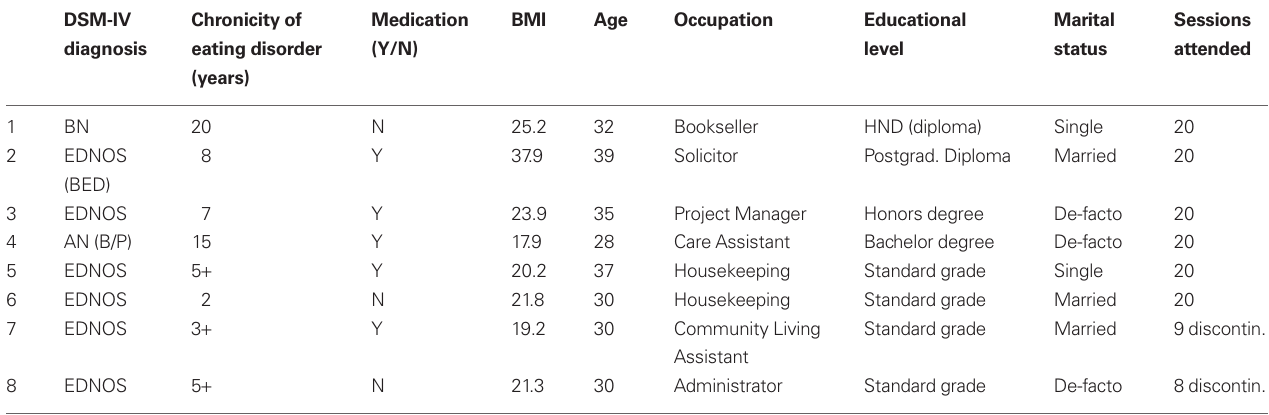
Table 1 | Sociodemographic data for eight group participants.